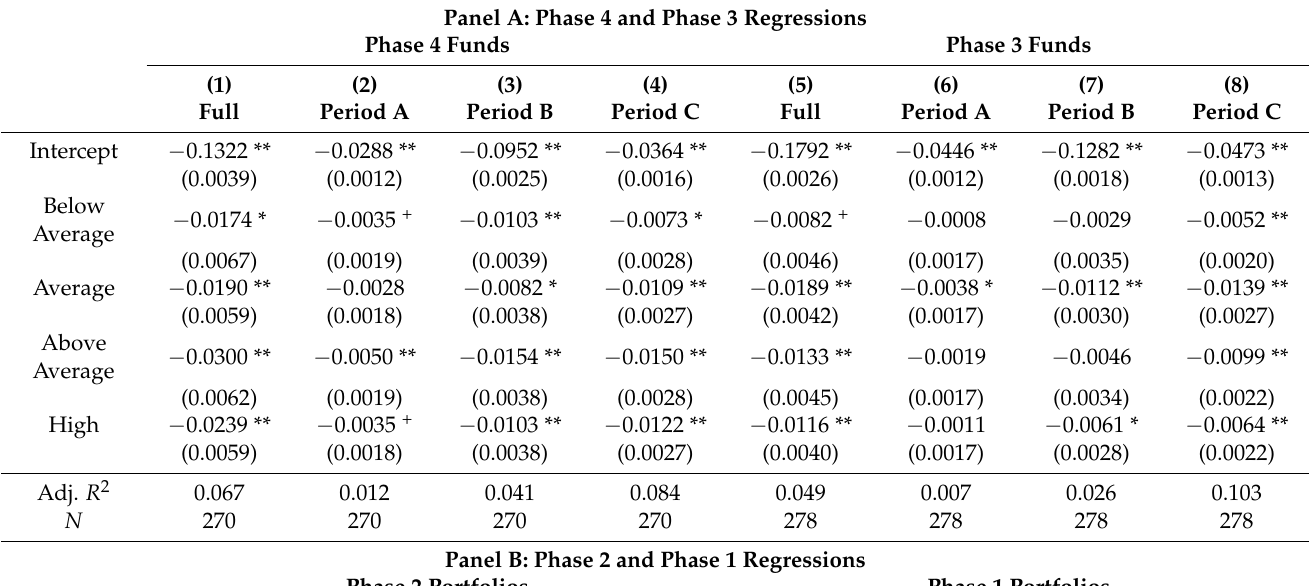
Table 9. Fee Level Drawdown Regressions by Phase. Panel A: Phase 4 and Phase 3